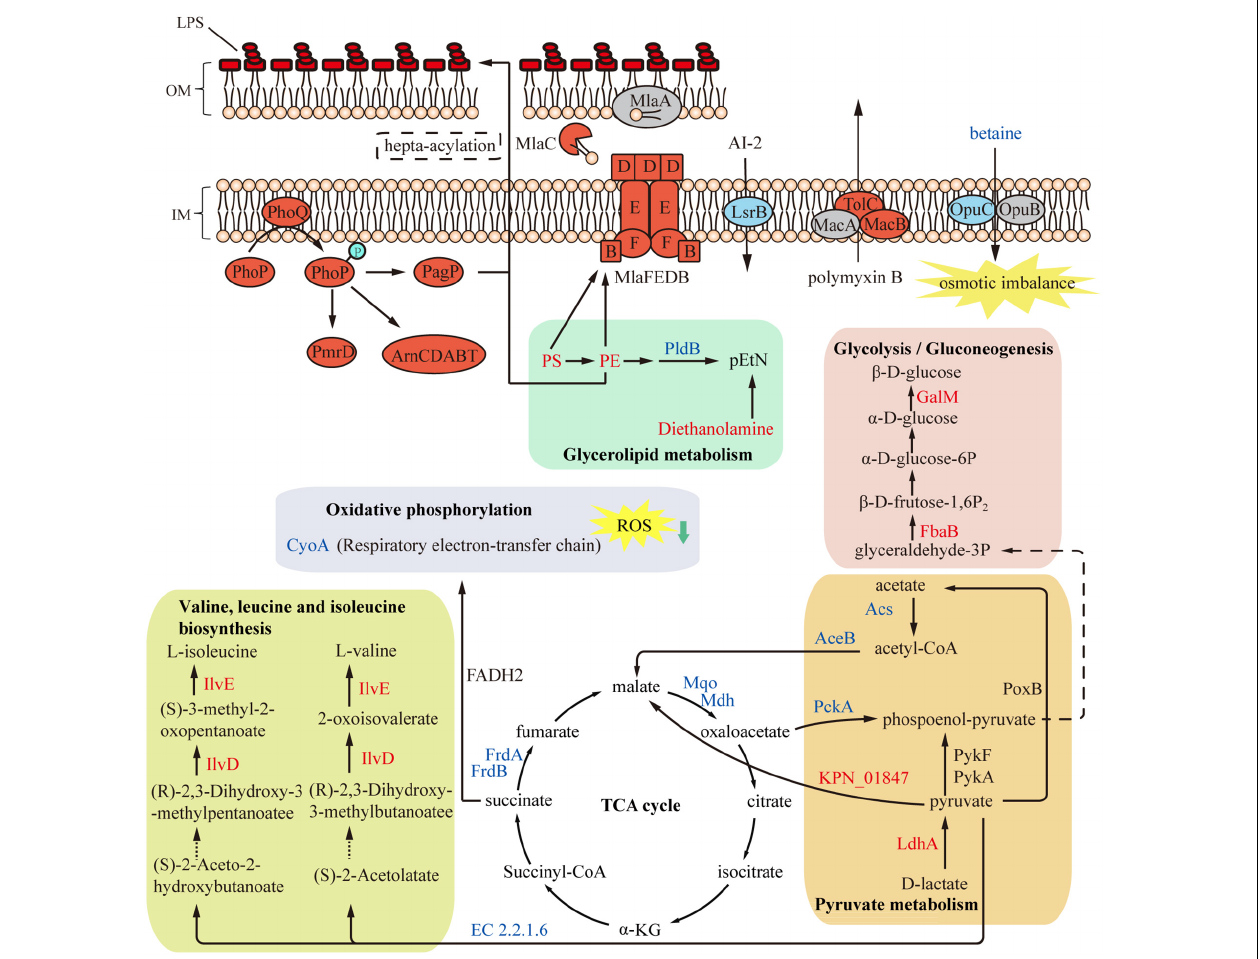
FIGURE 8 | Overview of metabolome and proteome differences between polymyxin B (PB) resistant and susceptible Klebsiella pneumoniae . Expression of several LPS-modifying enzymes was upregulated in PB-resistant K. pneumoniae , while the TCA cycle was inhibited and thereby production of ROS was reduced. Accumulated PS and PE in the glycerophospholipid metabolism were transported to the cell membrane through Mla system to strengthen the cell membrane. Red and blue represent upregulated and decreased proteins or metabolites (except LPS). Gray or black indicates proteins or metabolites with insignificant changes in